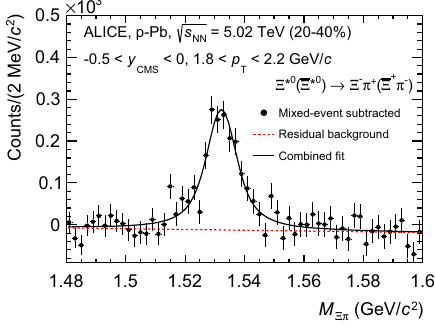
Fig. 3 ( Left ) the (cid:4) ∓ π ± invariant mass distribution (same-event pairs) in 1.8 < p T < 2.2 GeV / c and for the multiplicity class 20–40%. The background shape, using pairs from different events (mixed-event background), is normalised to the counts in